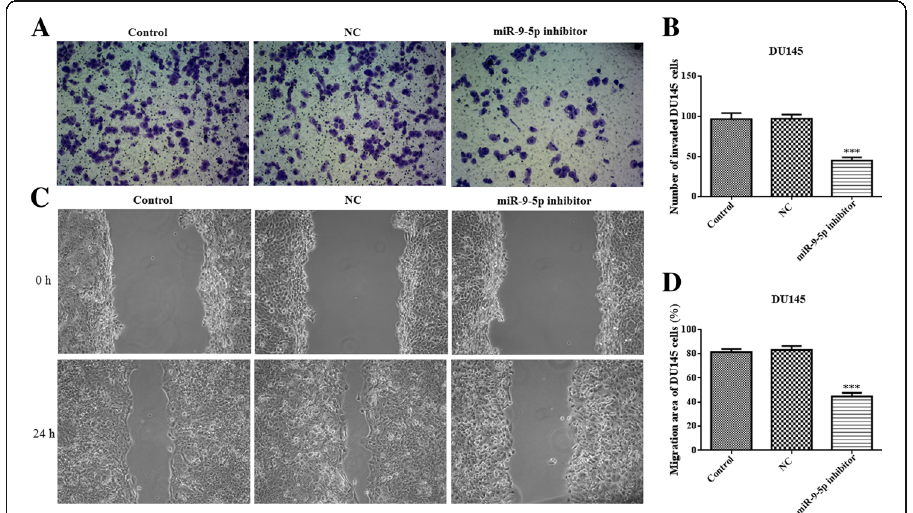
Fig. 3 Downregulation of miR-9-5p inhibits cell invasion and migration in DU145 cells. a through b - Cell invasion of DU145 cells with an miR-9-5p inhibitor or NC transfection was evaluated using a transwell assay. c through d - U145 cells were transfected with the miR-9-5p inhibitor and cell migration was assessed using the wound-healing assay. ** p < 0.01 vs. NC group; *** p < 0.001 vs. NC group. All experiments were performed with at least three